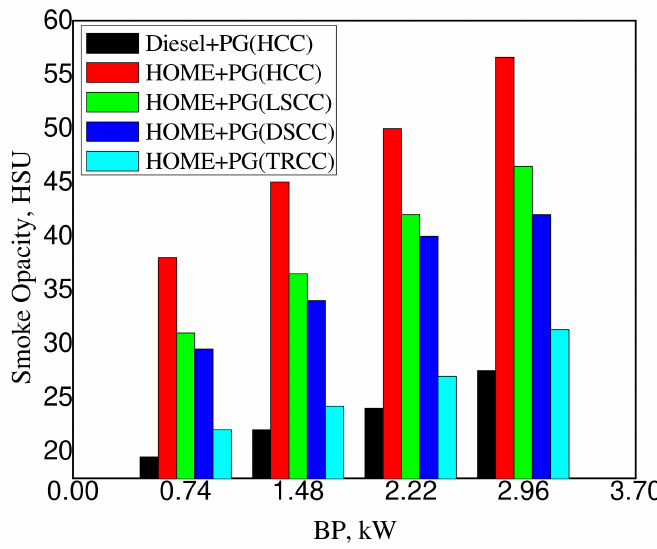
Figure 6. Effect of the combustion chamber type on smoke.